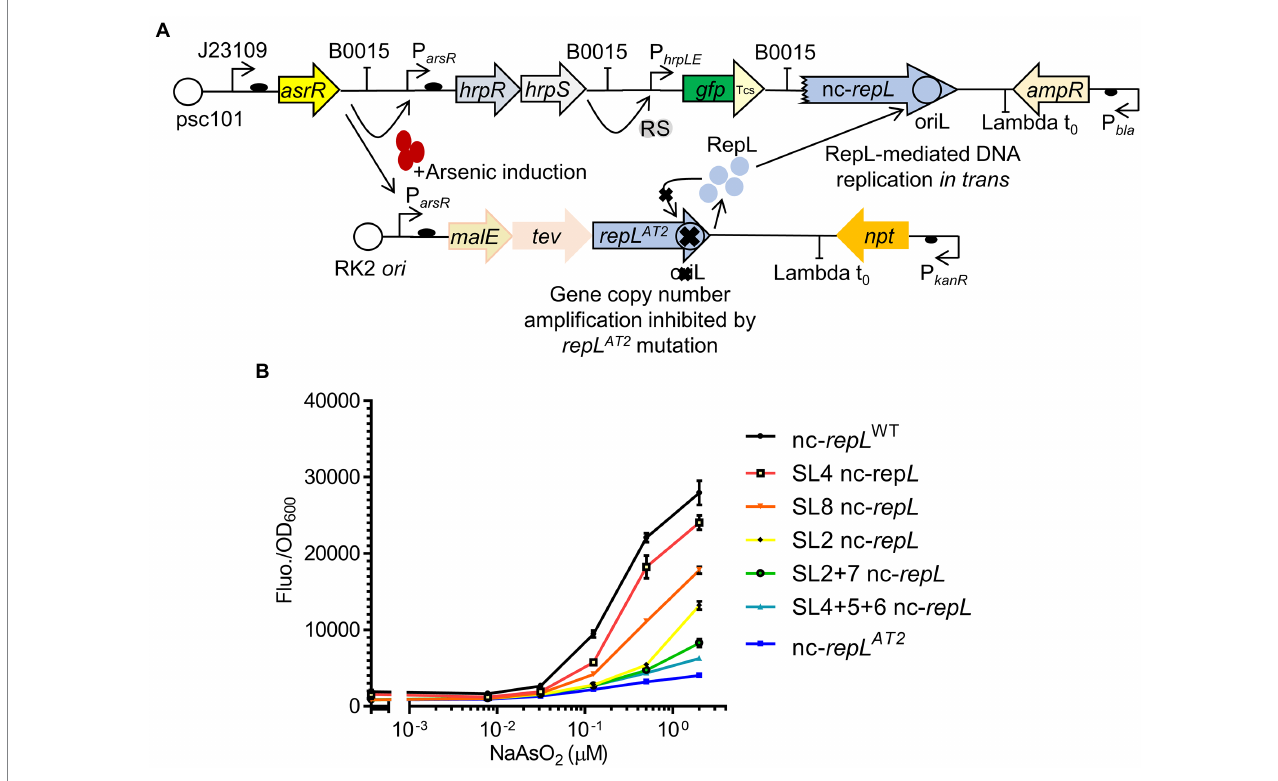
FIGURE 7 SL nc- repL sequences could modulate the output of an E. coli -based arsenic biosensor. (A) Schematic diagram showing the incorporation of repL AT2 gene and T2 nc- repL sequence into an arsR -based arsenic biosensor. The biosensor circuit consists of two separate plasmids. Presence of sodium arsenite/ arsenic induces the expression of hrpR , hrpS , as well as malE , tev and repL AT2 . RepL protein would promote DNA replication of the gfp reporter plasmid containing a nc- repL sequence. This would give an increase in GFP fluorescence intensity. The mutant repL AT2 allele would inhibit amplification of its gene copy number in cis . GFP has a Tev protease degradation tag (Tsc) which reduced the background protein level at uninduced state. (B) GFP fluorescence intensity per OD 600 of TOP10 cells (Fluo./OD 600 ) transformed with the arsenic biosensor having a wildtype (nc- repL WT , in black), nc- repL AT2 (blue), SL4 nc- repL (red), SL8 nc- repL (orange), SL2 nc- repL (yellow), SL2 + 7 nc- repL (green), SL4 + 5 + 6 nc- repL (teal) sequences, at 5 hpi with 0.0781 μ M, 0.031 μ M,